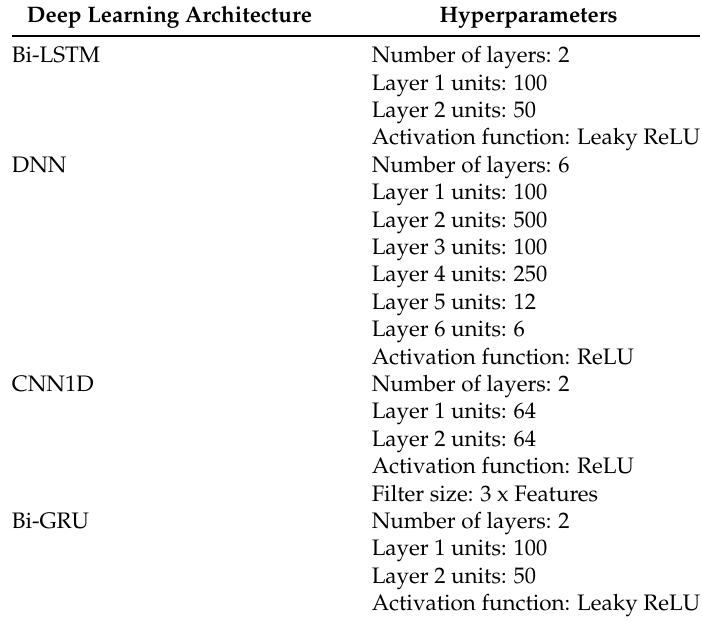
Table 2. Hyperparameters of all models used to test the new loss function presented in Section